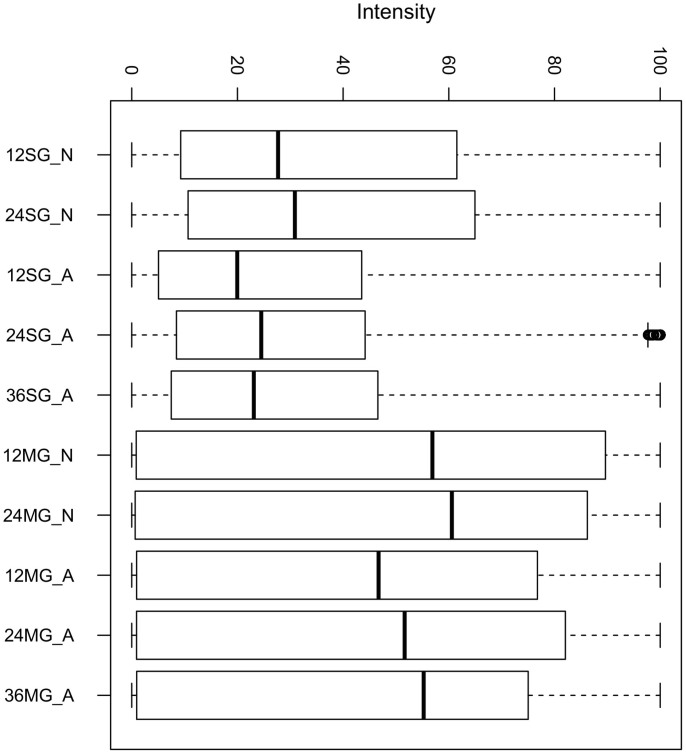
The breadth of tissue- and time-dependent differential expression.A box plot was constructed using normalized reads per kilobase per million (RPKM) values for CDS with a total RPKM (considering the reads of all ten libraries) of 50 or larger to avoid inclusion of poorly expressed contigs. The normalized RPKM values (maximum 100) for ten different libraries from Ixodes ricinus are as follows: the first two numbers indicate the time point of organ collection from 0–12 h (12), 12–24 h (24), or 24–36 h (36). Organs were either salivary glands (SG) or midguts (MG) and developmental stage was either nymphs (N) or adults (A). For more details, please consult the methods.